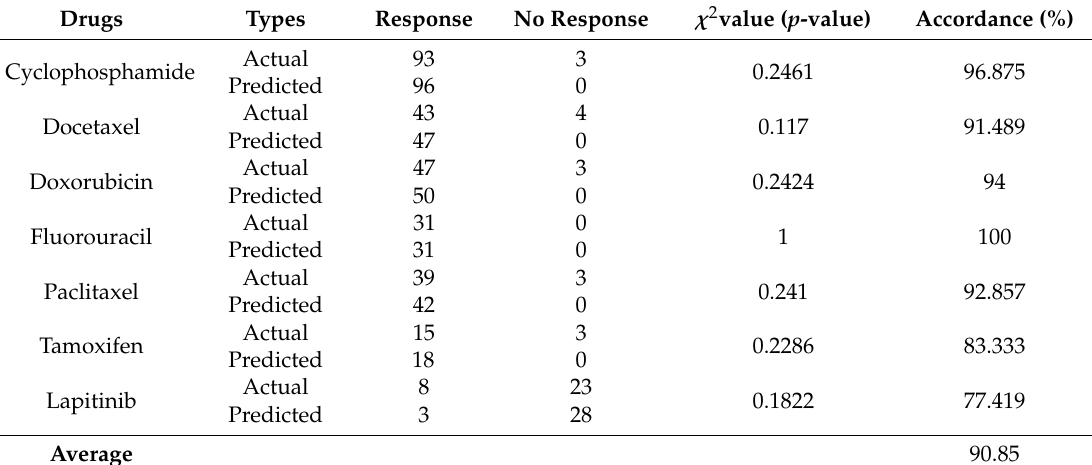
Table 3. Contingency table to compare drug response accordance between the prediction and real values for seven